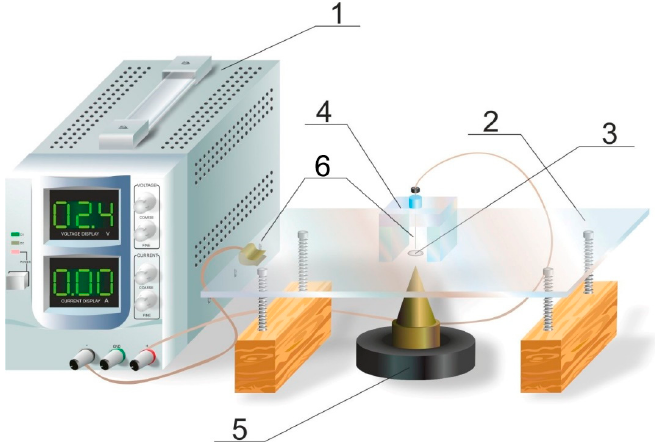
Figure 1. Schematic representation of the experimental setup used in this study. Power source (1); conducting glass (2); magnetic fluid drop (3); airflow cover (4); permanent magnet (5); needle electrode (6).